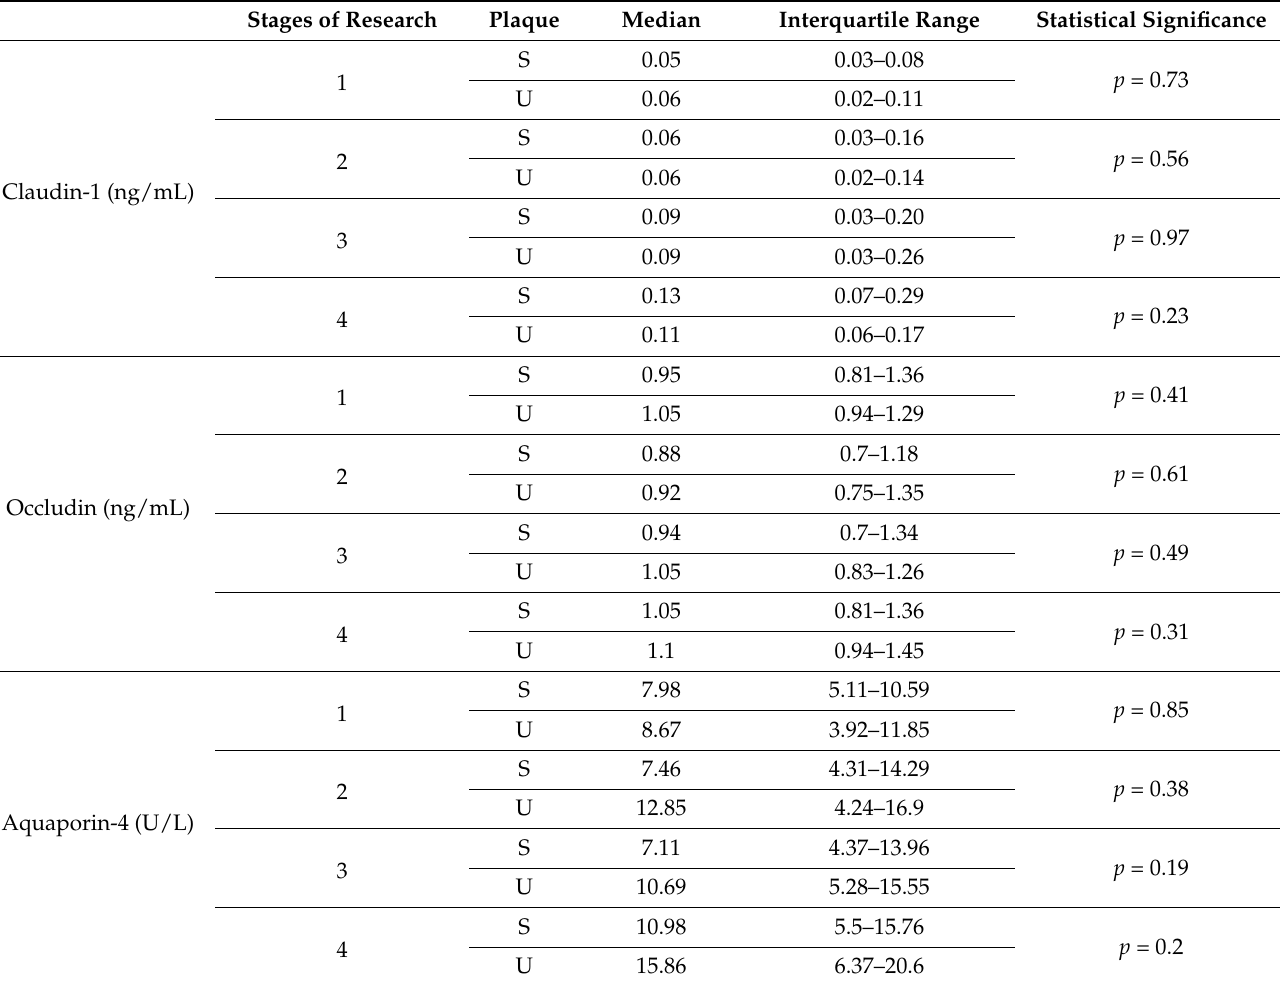
Table 3. Analysis of claudin-1, occludin, aquaporin-4, S100 β protein, MMP-4, and MMP-9